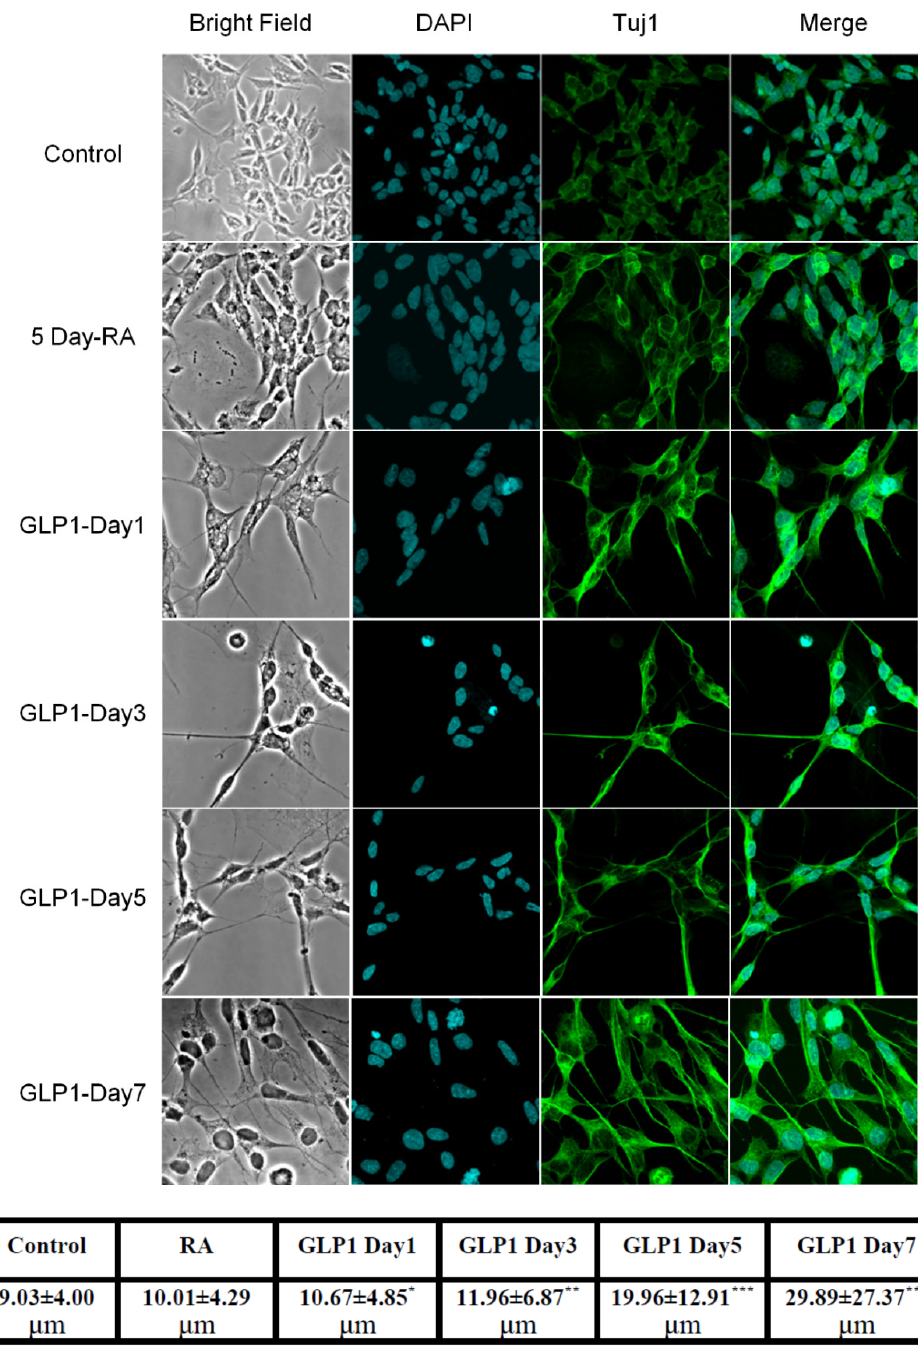
Figure 2. GLP-1 promoted SH-SY5Y cell differentiation into morphologically mature neurons . TUJ1 immunocytochemistry images demonstrated that only 5-day retinoic acid (RA) treated SH-SY5Y cells showed differentiating short neurites (second row); RA-preconditioned SH-SY5Y cells grew longer neurites and altered spindles, developing round cell bodies, after GLP-1 treatment. According to the treatment time with GLP-1, neuroblastoma had differentiated into mature neuron-like morphologies. The bottom table demonstrates quantitated average length of neurites in each group. The GLP-1 treated SH-SY5Y cells grew longer neurites on the 3rd day, and almost all cells had significantly longer neurites on the 7th day post-treatment. (M ± SD, the statistical significance was compared with value of control group, * p < 0.05; ** p < 0.01; *** p < 0.001, n = 50).